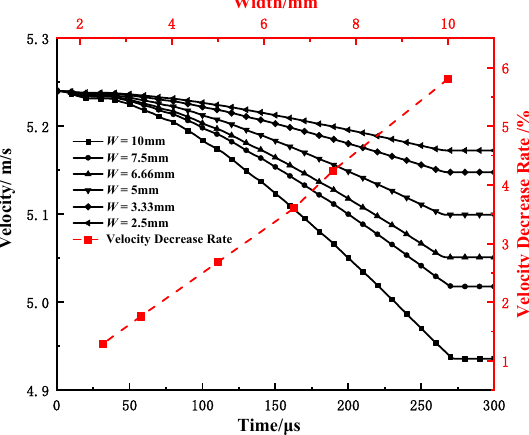
Figure 21. Effect of specimen width on velocity variations.